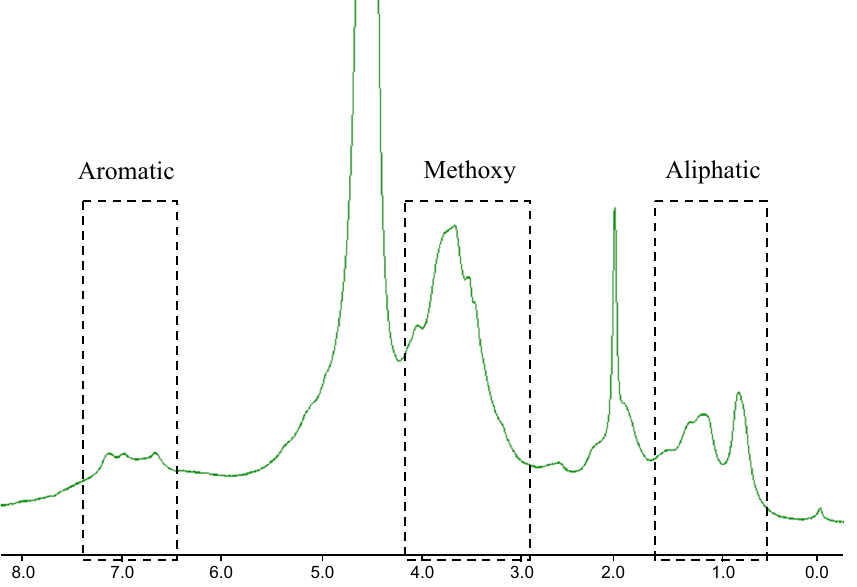
Figure 4. 1 H-NMR spectrum [400 MHz, D 2 O: acetone- d 6 (1:1)] of the > 3 kDa fraction of the corn silk water extract.